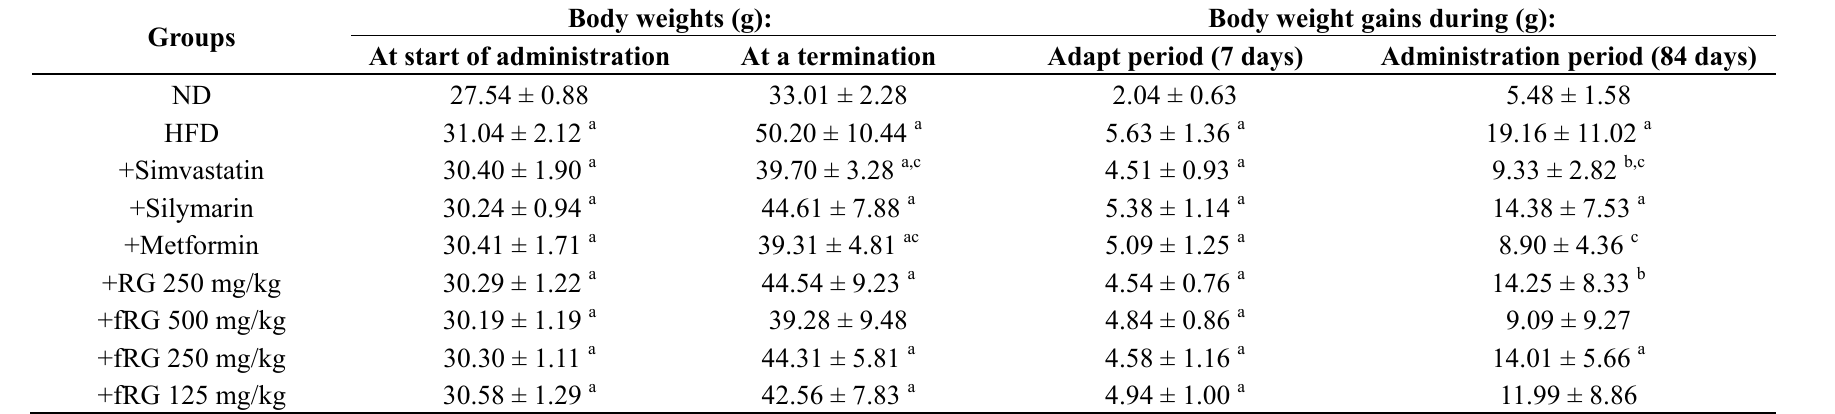
Table 1. Body weight gains after 84 days of continuous oral treatment of fRG in HFD-fed mice.